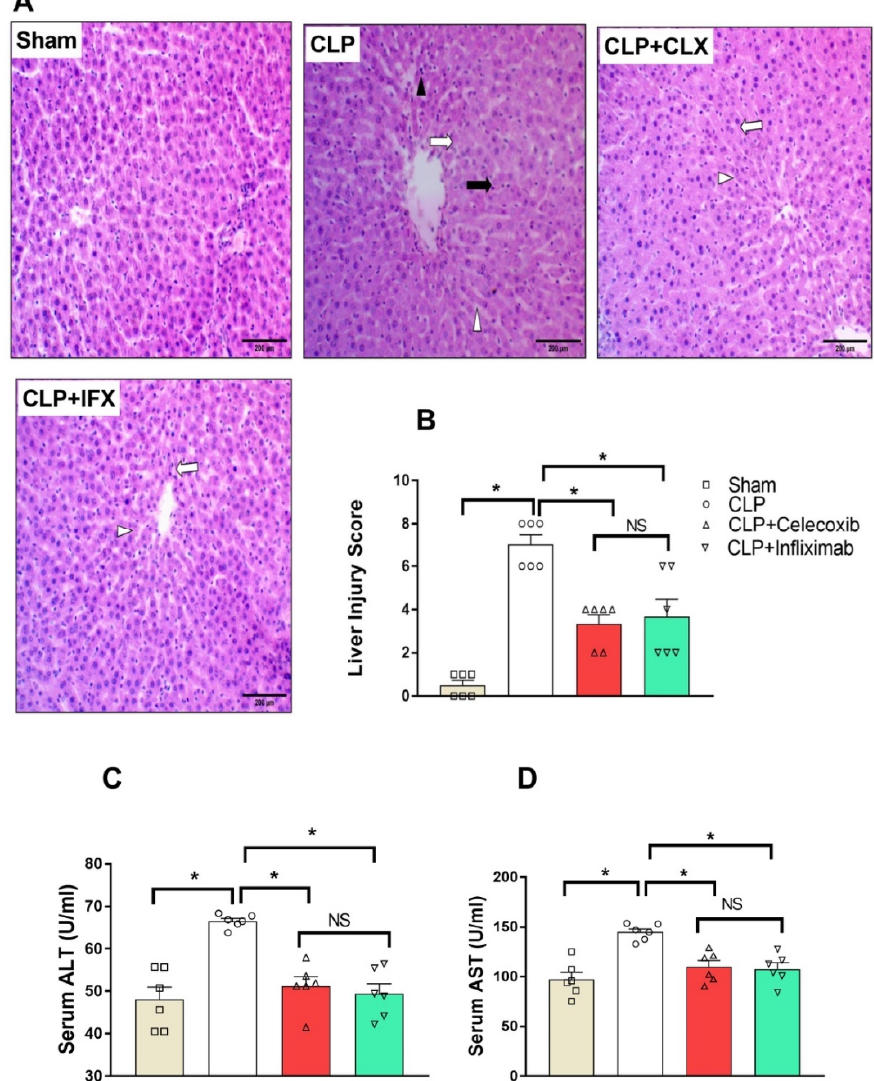
Figure 4. Effect of CLP and treatment with CLX and IFX against sepsis-induced AHI. ( A ) Pho- tomicrographs showing the effect of CLX and IFX administration on sepsis-induced liver